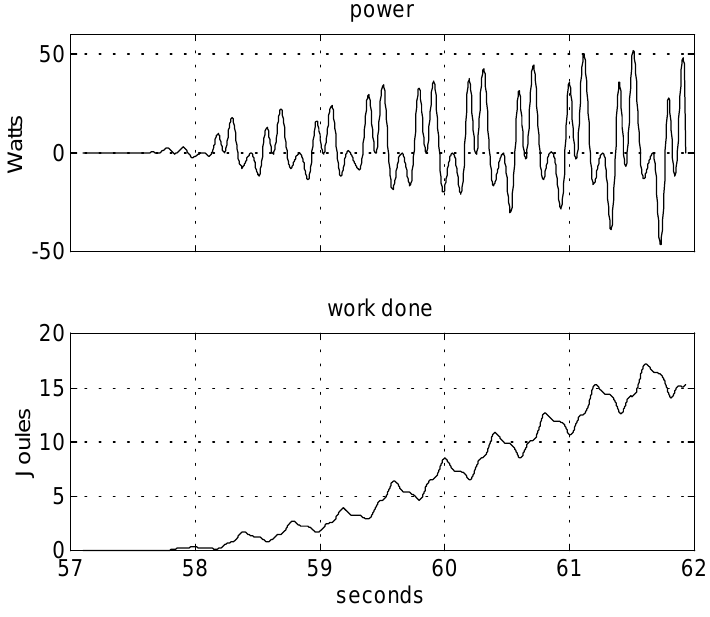
Fig. 8. Upper: Power supplied to bridge derived from contact force and acceleration. Lower: Time integral of power; energy supplied to bridge. different subjects (human dampers) were used and because a perfectly repeatable loading could not be generated, the additional damping was studied from the ratio of measured energy loss in a cycle to total energy. energy E i.e.